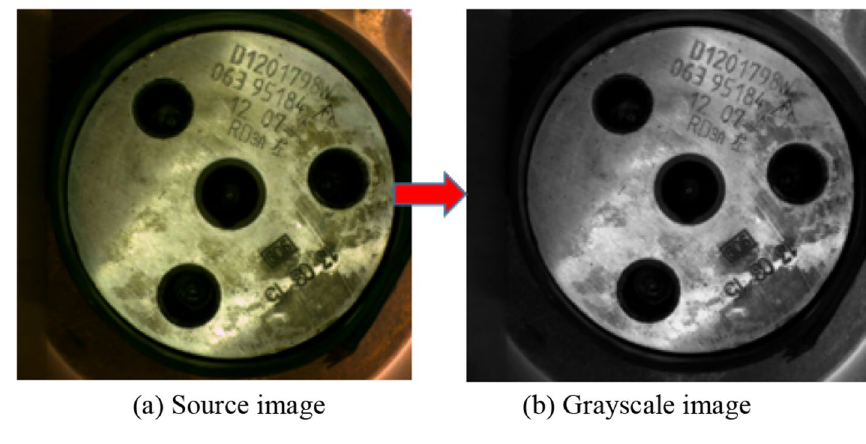
Fig. 6 Gray processing